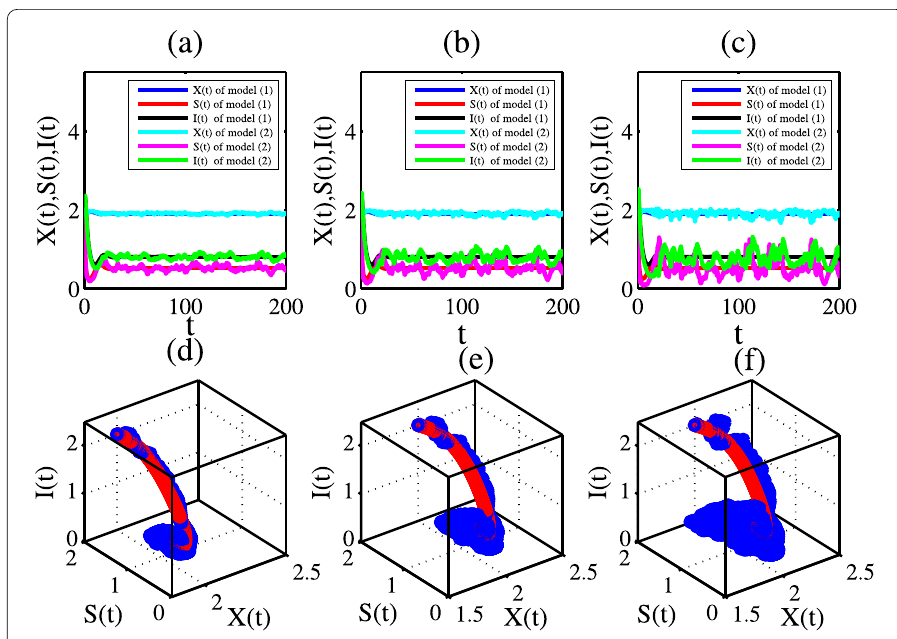
Figure 3 Time sequence diagram and phase portrait of model (2). (a) The Brownian motion model with σ 12 = σ 21 = σ = 0.03,0.06,0.1, respectively. (d) - (f) are phase portraits of (a) - (c) , respectively. The red ◦ is corresponding to the deterministic model, while the blue ◦ represents the stochastic